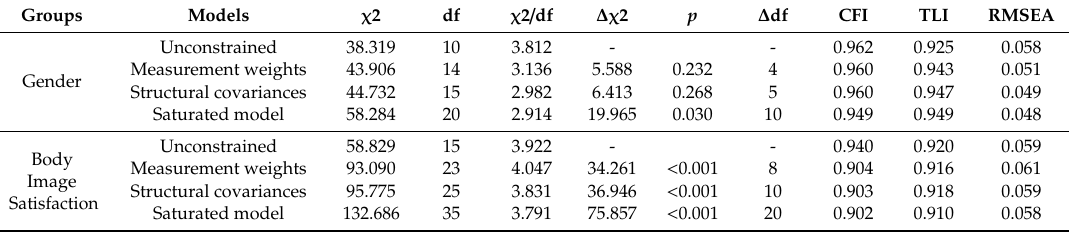
Table 1. Multigroup analysis of invariance by gender and degree of conformity with the